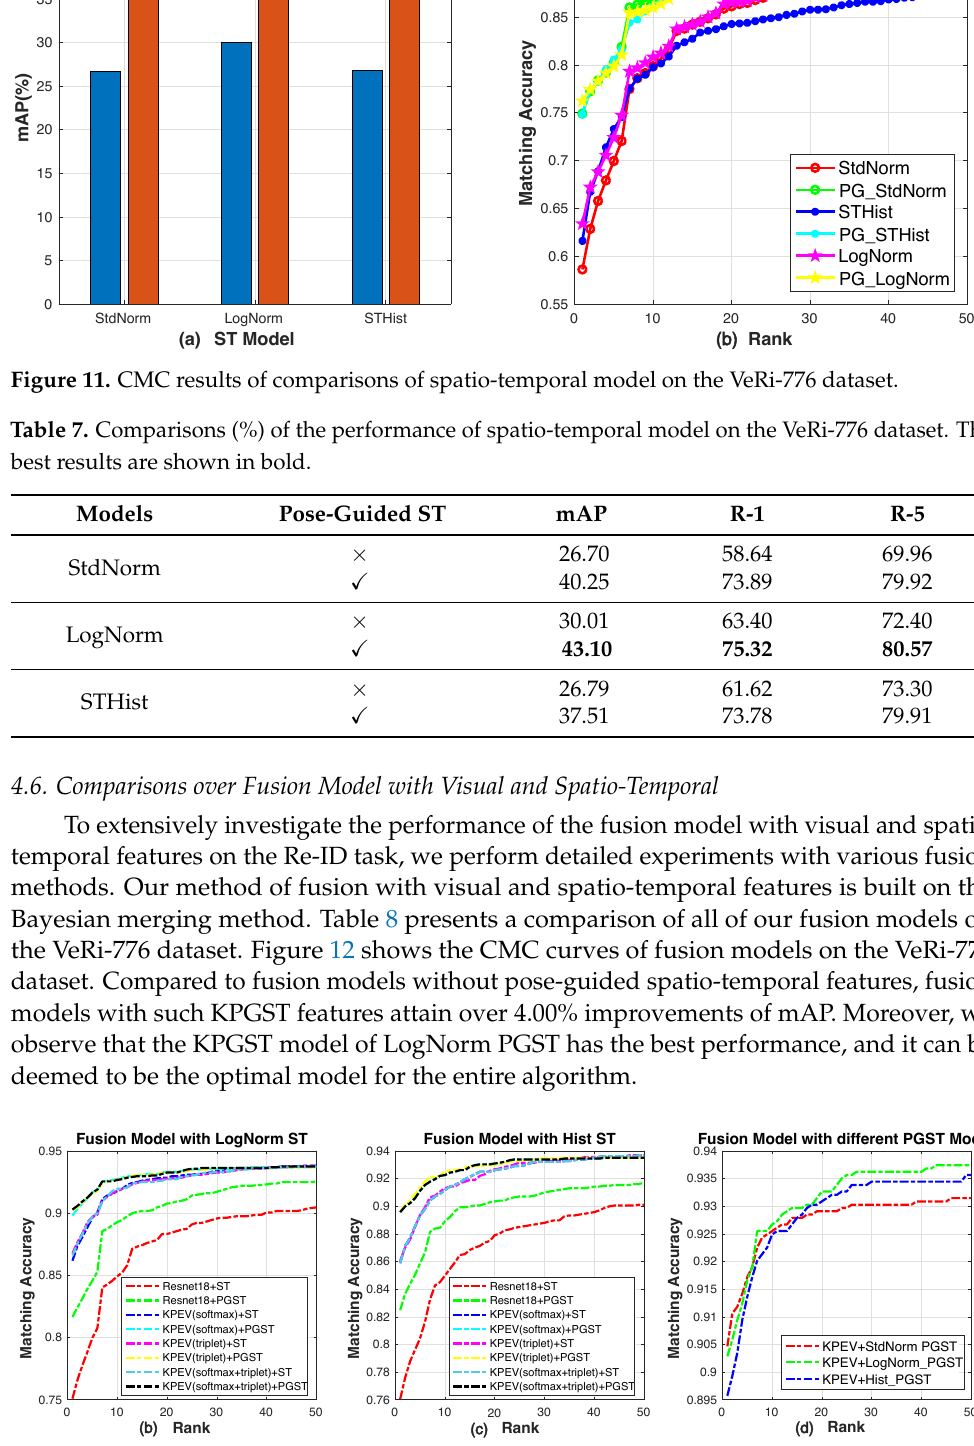
Figure 12. CMC results of comparisons of our fusion model on the VeRi-776